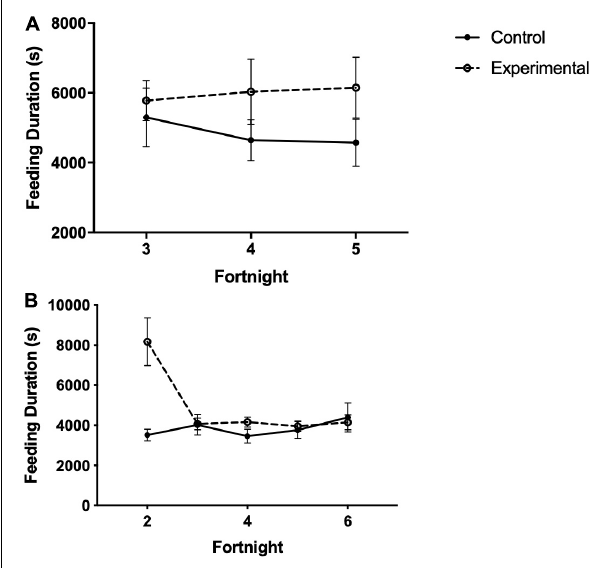
FIGURE 7 | Feeding duration (time spent at the food cup) in seconds of white-throated sparrows exposed to (A) low-frequency inclement weather